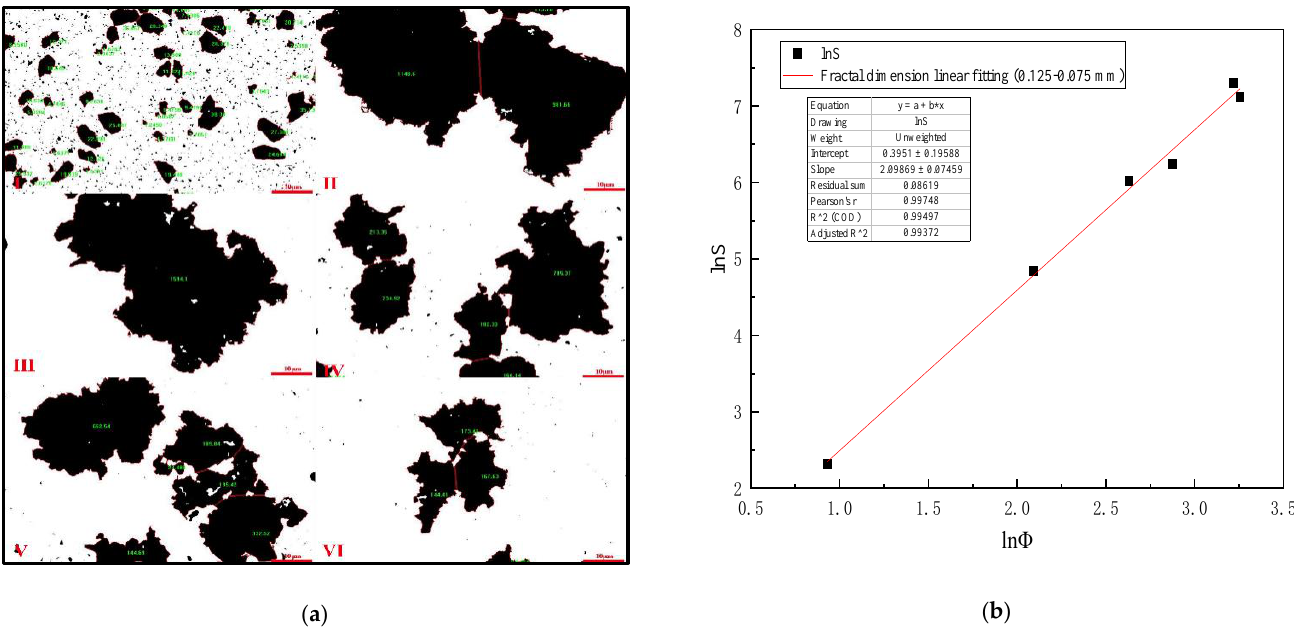
Figure 9. ( a ) Area diagram of 0.125–0.075 mm coal slime floc at different mixing speeds. ( I ) 0, ( II ) 200 r/min, ( III ) 400 r/min, ( IV ) 600 r/min, ( V ) 800 r/min, ( VI ) 1000 r/min; ( b ) Fractal dimension fitting diagram of settling floc of 0.125–0.075 mm coal slime. 4.5. Mixing Speed versus Equivalent Diameter of Settling Floc (0.075–0.045 mm Slime) Table 9 is analyzed by Image-Pro-Plus 6.0 software and (Formulas (15)–(17)), which shows that when the mixing speed is 200 r/min, the equivalent diameter of 0.075–0.045 mm slime settling floc is the largest, and the settling speed of slime floc is the fastest on the microscopic level. Figure 10a is the analysis diagram of floc area of 0.075–0.045 mm slime at the mixing speed of 0–1000 r/min. Figure 10b shows the fractal dimension fitting diagram, when the mixing speed is 0–1000 r/min, the mean fractal dimension of 0.075–0.045 mm coal slime floc is 2.073. Table 9. Mixing speed versus equivalent diameter of settling floc (0.075–0.045 mm slime).